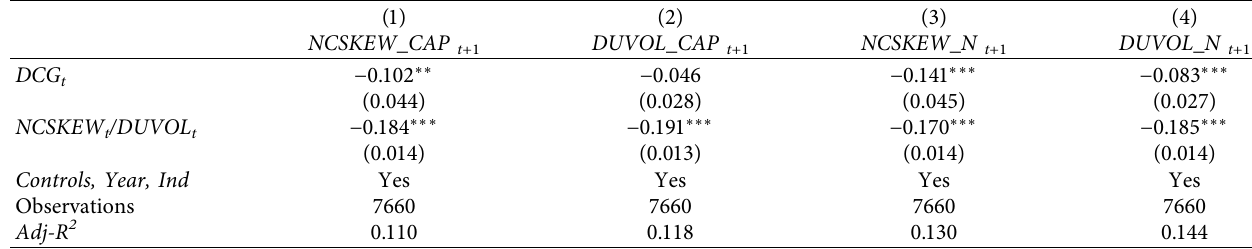
Table 10: Robustness test: change the calculation method of stock price crash